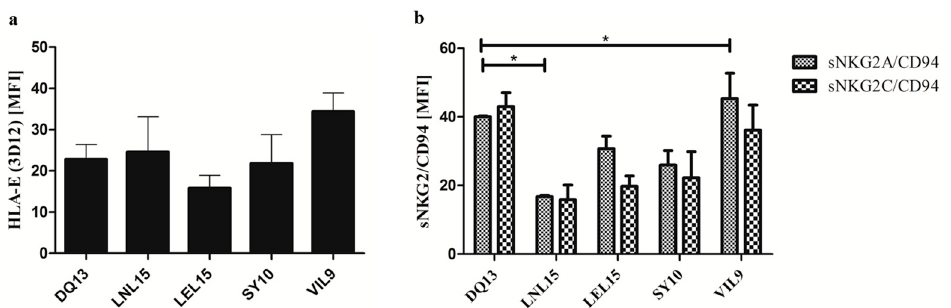
Figure 2. HLA-E surface expression and binding of sNKG2/CD94 receptors to distinct p:HLA-E complexes. ( a ) HLA-E cell surface levels on T2E cells (as MFI = median fluorescence intensity)